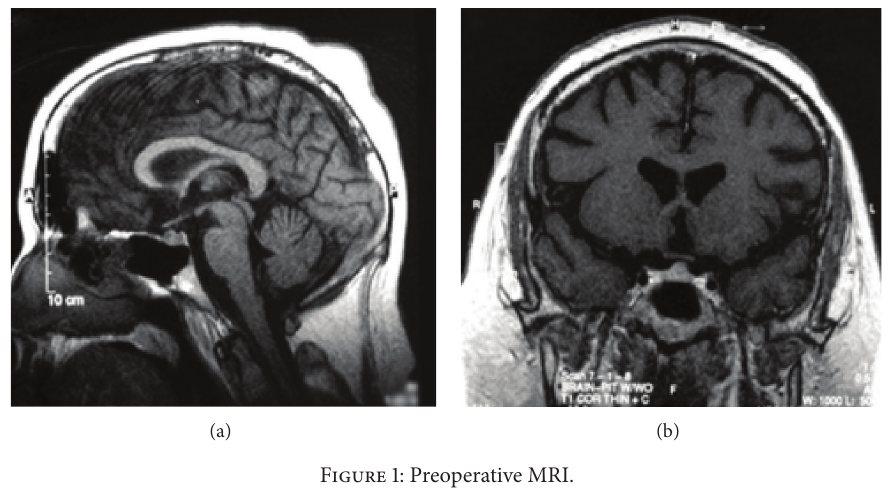
Figure 1: Preoperative MRI.